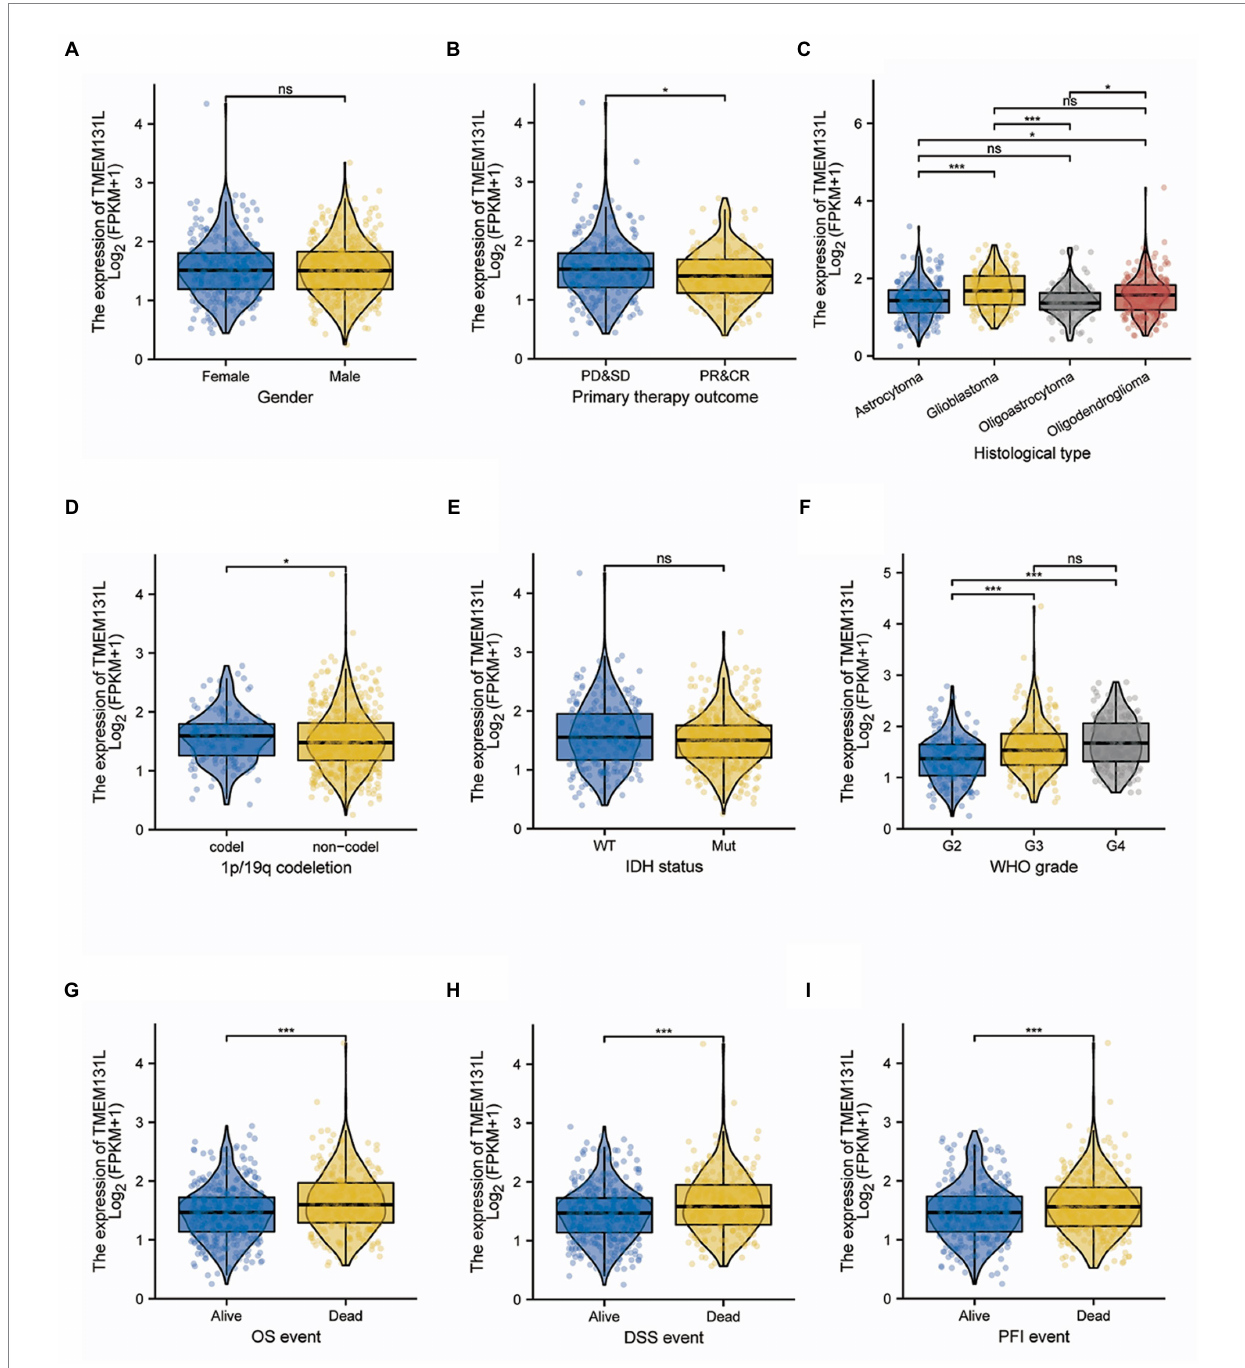
FIGURE 6 Correlation between TMEM131L expression and clinicopathological features in the TCGA-GBMLGG dataset. (A–F) Differences in expression of pathological parameters between subgroups; (G–I) Expression difference of TMEM131L in GBM and LGG patients under different OS, PFI, and DSS survival